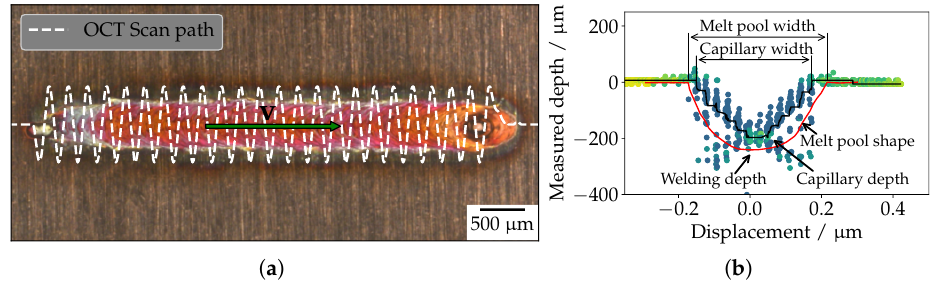
Figure 10. ( a ) Weld seam image overlaid with a sinusoidal OCT beam movement path perpendic- ular to the welding process; ( b ) possible extractable process information when using the scanned OCT